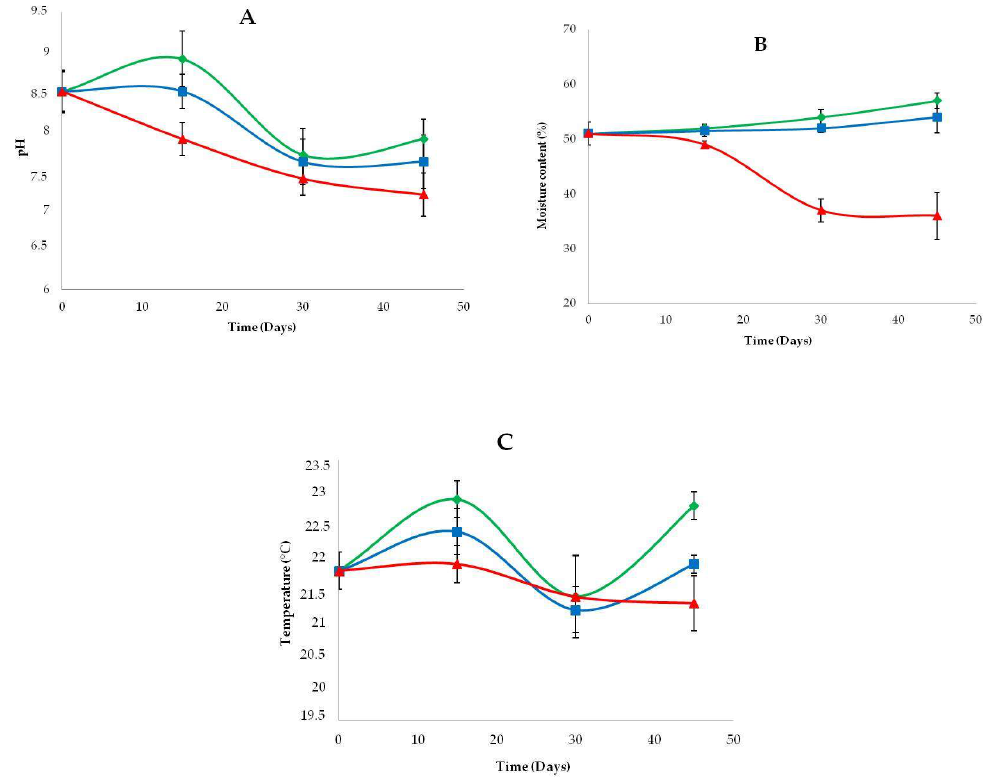
Figure 2. Evolution of pH ( A ), moisture ( B ), and temperature ( C ) during 45 days of treatment. Treatment with carrot peel waste ( (cid:7) ); Treatment with carob kibbles ( ■ ); and Control without treatment ( ▲ ). Error bars represent the standard error of replicates.